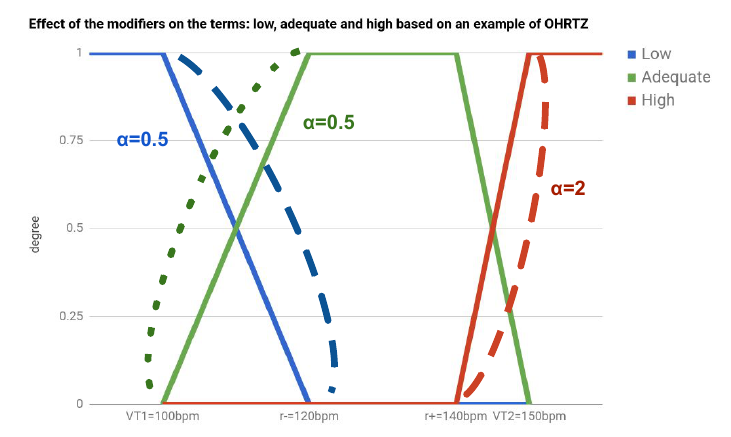
Figure 1. Example of membership functions for the terms low, normal, and high. In the example, the optimal heart rate training zones (OHRTZs) of the sessions are for trained patients, which are closer to VT 2 than to VT 1 . In the example of modifiers, the impacts of the weak modifier in short-dashed lines and the strong modifier in long-dashed lines are